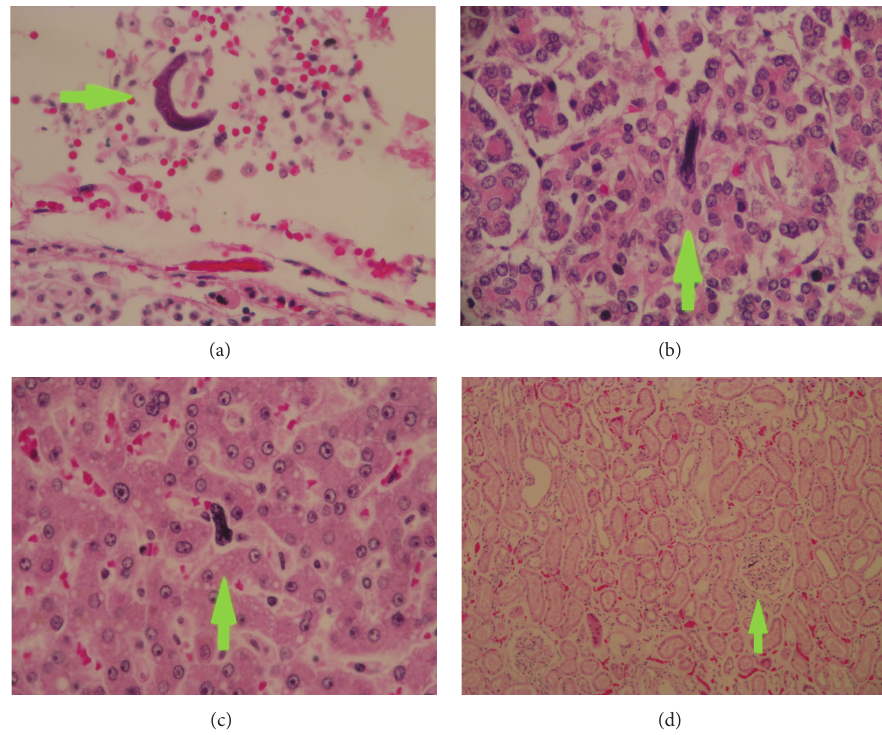
Figure 2: (a) Filariform larvae of S. stercoralis longitudinally sectioned in lung tissue, (b) in thyroid tissue, and (c) in liver tissue; the arrows point the larvae, hematoxylin and eosin staining, magnification × 40. (d) Glomerulus with a filariform larva of S. stercoralis longitudinally sectioned, hematoxylin and eosin staining, magnification ×